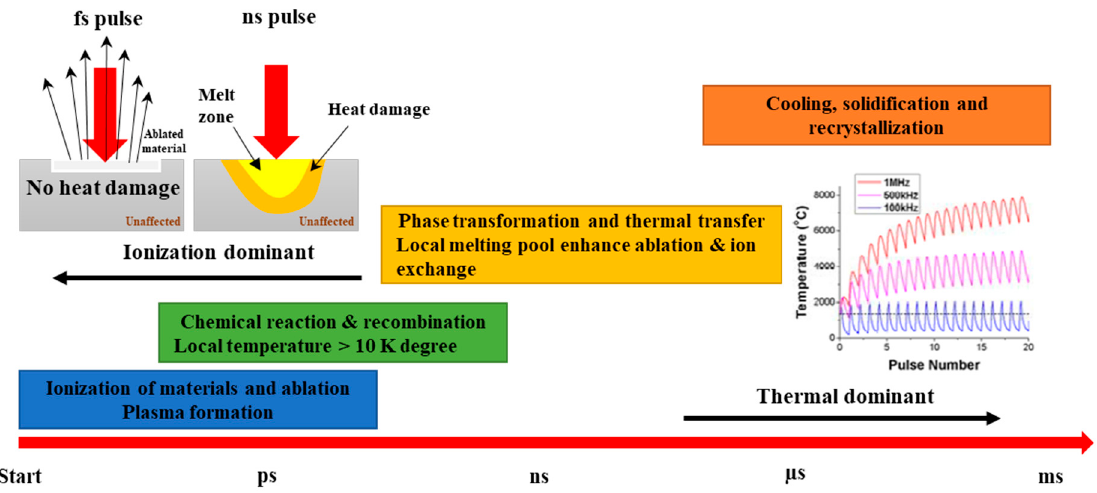
Figure 4. Temporal evolution of an fs-laser-based AM process [44]. The inset shows the correlation between pulse number and temperature for different repetition rates.